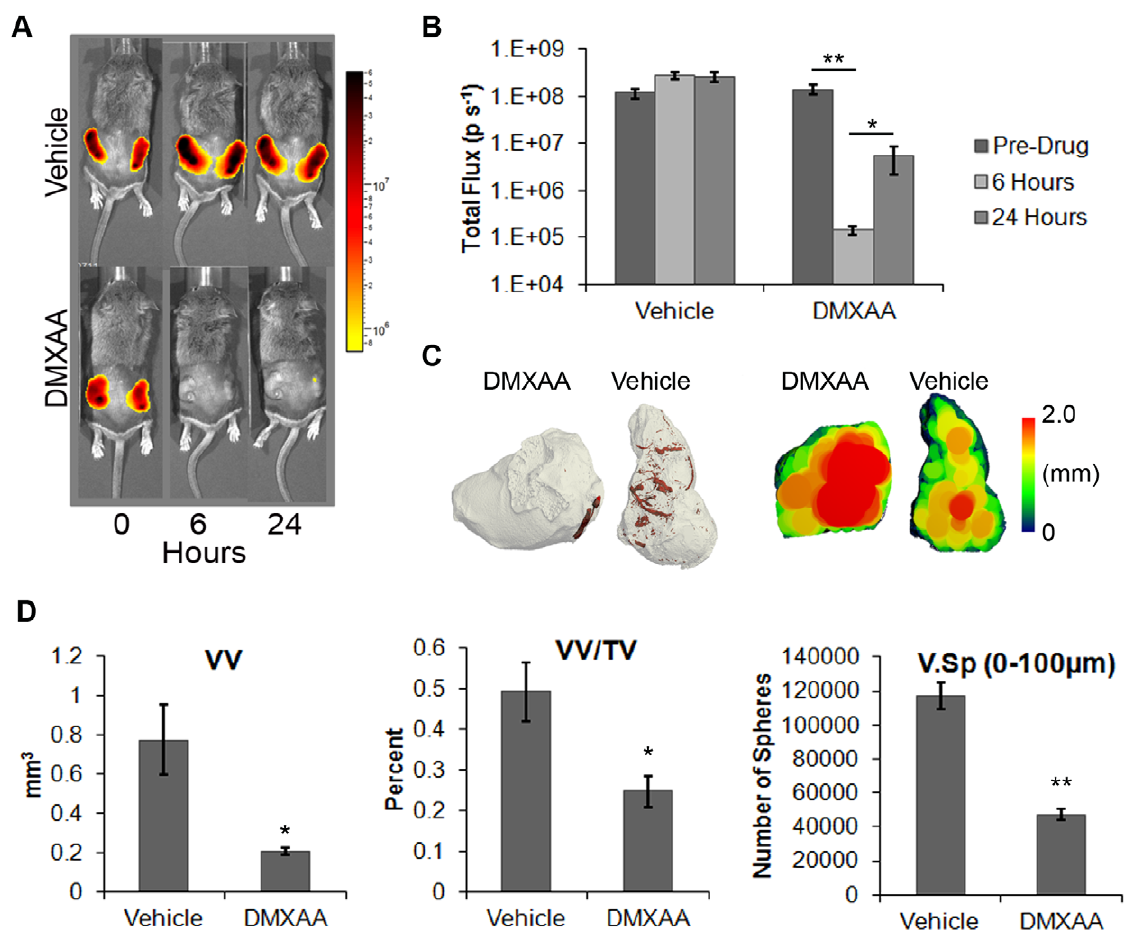
Figure 5. Assessing the effects of a vascular disrupting agent. ( A ) Bioluminescence images of luciferase-expressing 344SQ-EL cell line-derived subcutaneous tumors. Images were taken prior to treatment, and again at 6 and 24 hrs post DMXAA treatment. This agent led to a dramatic loss of bioluminescence. ( B ) Quantification of changes in photon emission rates of the DMXAA-treated, and control tumors (data represent averages 6 s.e.m., N=20). ( C ) 3-D micro-CT surface renderings (gray and red) and cross-sectional maximal-spheres filling model rendering (red = vessel diameters of 2 mm or greater) for representative subcutaneous tumors treated with either DMXAA or vehicle control, and perfused with Microfil after 24 hrs. The images demonstrate a large increase in the necrotic regions following DMXAA treatment. ( D ) Quantification of the vessel volume, density, and separation of DMXAA-treated tumors. There was a decrease in vessel volume and density, and in well-vascularized areas, as indicated by the drop in spheres present with sizes between 0–100 m m. This result was consistent with an increase in the size of the necrotic areas in the DMXAA-treated tumors. Data indicate averages 6 s.e.m., N=6 per sample. Asterisks indicate: * p , 0.05, ** p , 0.01.